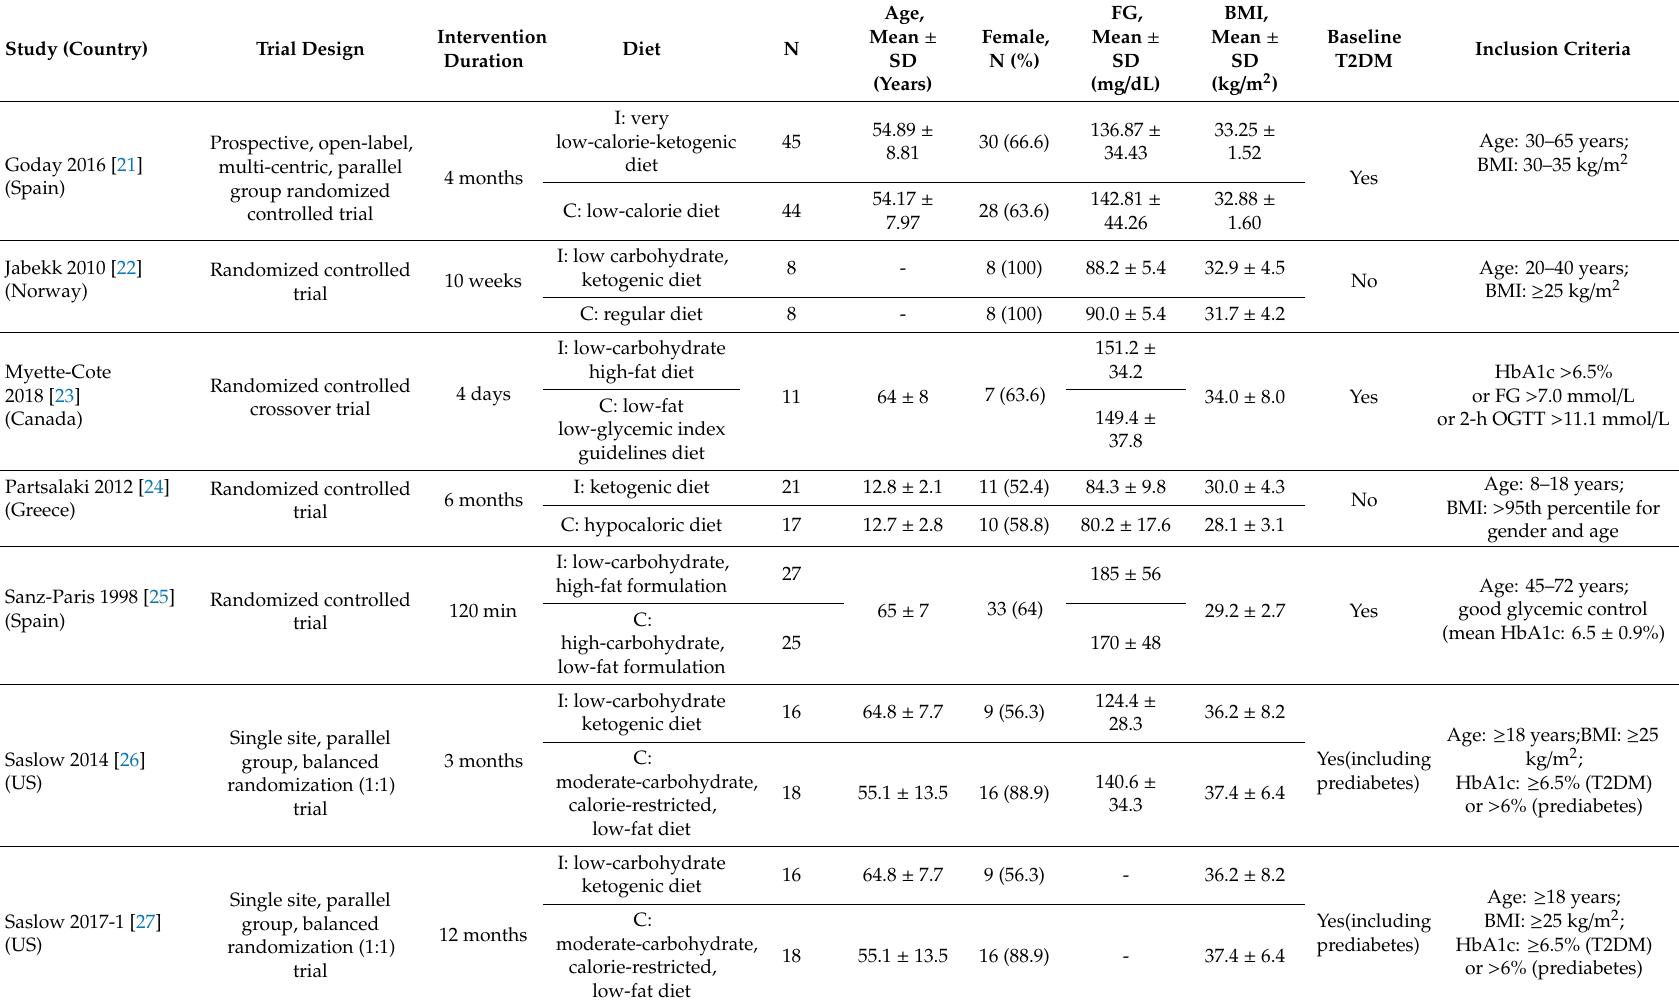
Table 1. Characteristics of included